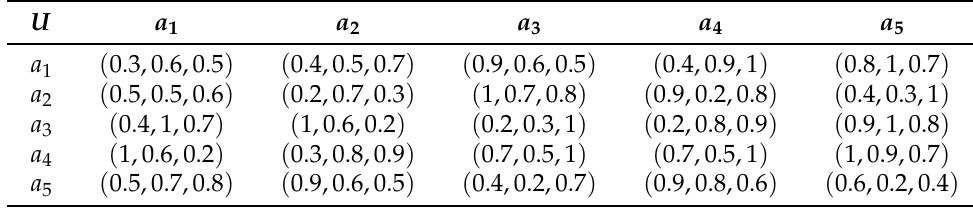
Table 3. The tabular representation of a three-way fuzzy relation R .